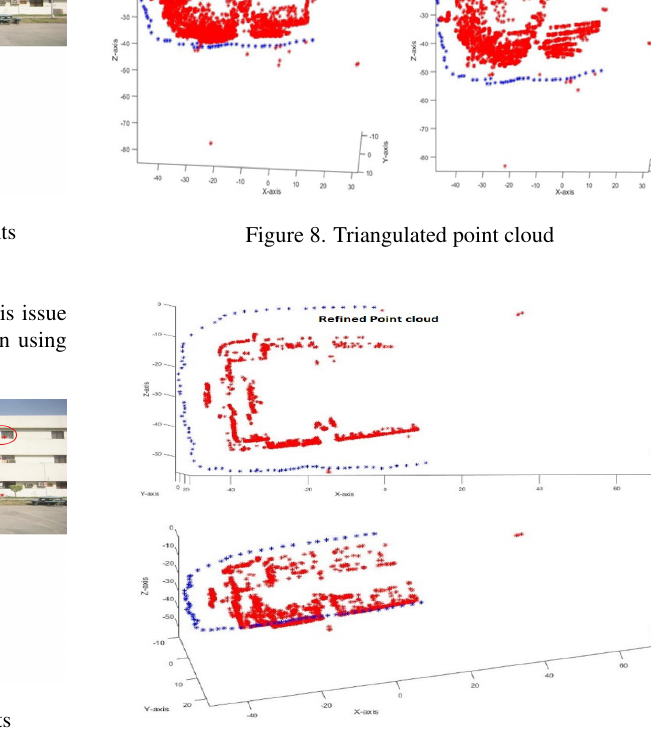
Figure 9. Bundle Adjusted point cloud